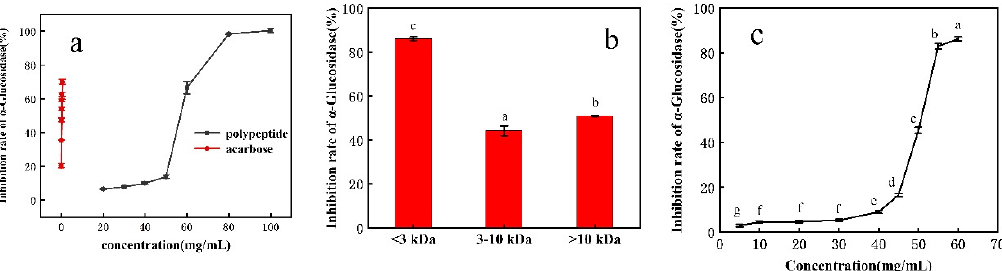
Figure 1. α -glucosidase inhibition activity of ( a ) crude rice bran peptides, ( b ) bioactive peptides after ultrafiltration, and ( c ) bioactive peptides of <3 kDa. ultrafiltration, and ( c ) bioactive peptides of <3